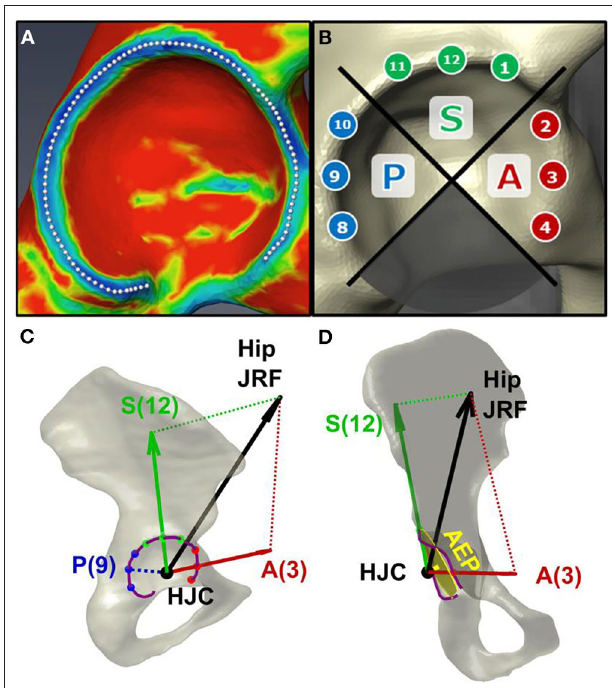
FIGURE 2 | Estimation of acetabular edge loading (AEL). (A) The acetabular rim of each subject was delineated using a principal curvature heat map. (B) Nine clock-face points were designated on the anterior (“A”), superior (“S”), and posterior (“P”) quadrants of the rim. (C) AEL magnitudes were estimated via trigonometric projection of the hip JRF (black arrow) along the directions from HJC toward each clock-face point on the rim (red/green arrows). The JRF-to-edge angle was calculated as the angle between the JRF and the AEL directions (i.e., between black and red/green arrows). Note zero posterior AEL when JRF is directed anteriorly. (D) An “acetabular edge plane (AEP)” was fit to the rim to measure the distance between the approximated acetabular border and the HJC.